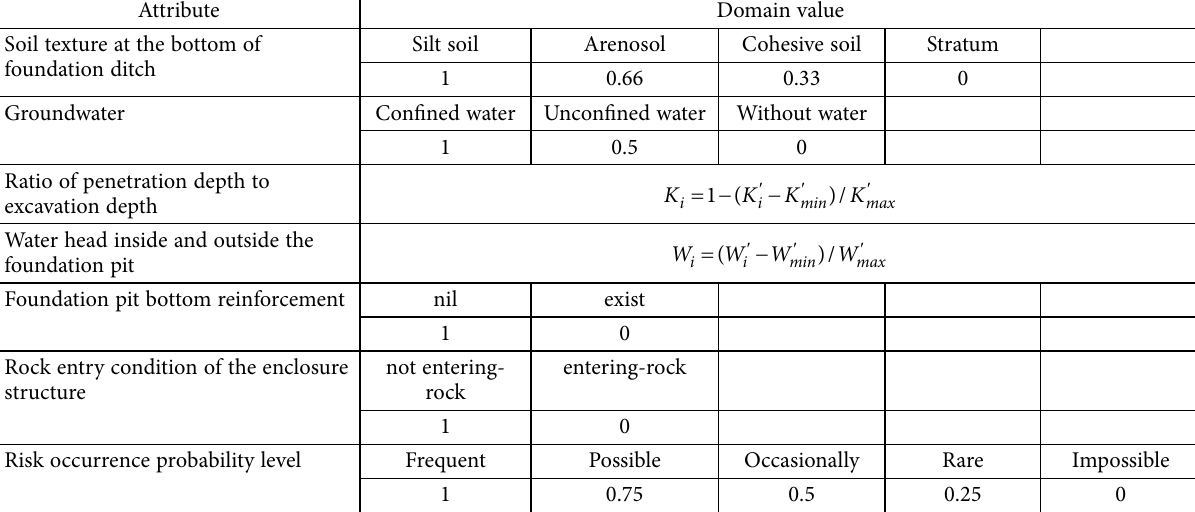
Table 10. Attribute value preprocessing control